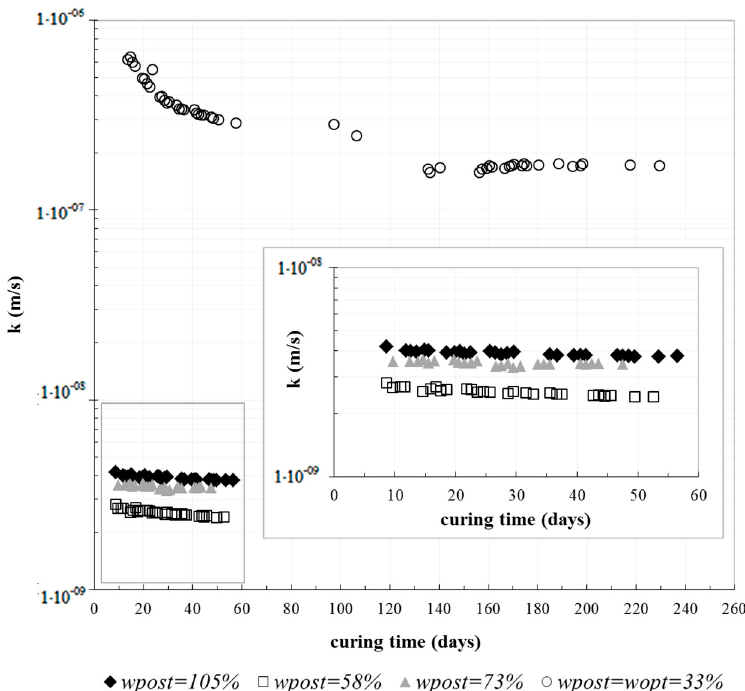
Figure 8. Hydraulic conductivity of soil treated with 7% CaO as a function of curing time. Very long-term test on the specimen compacted at w = 33% and tests on specimens compacted at w > 55%, i.e., wet of optimum.